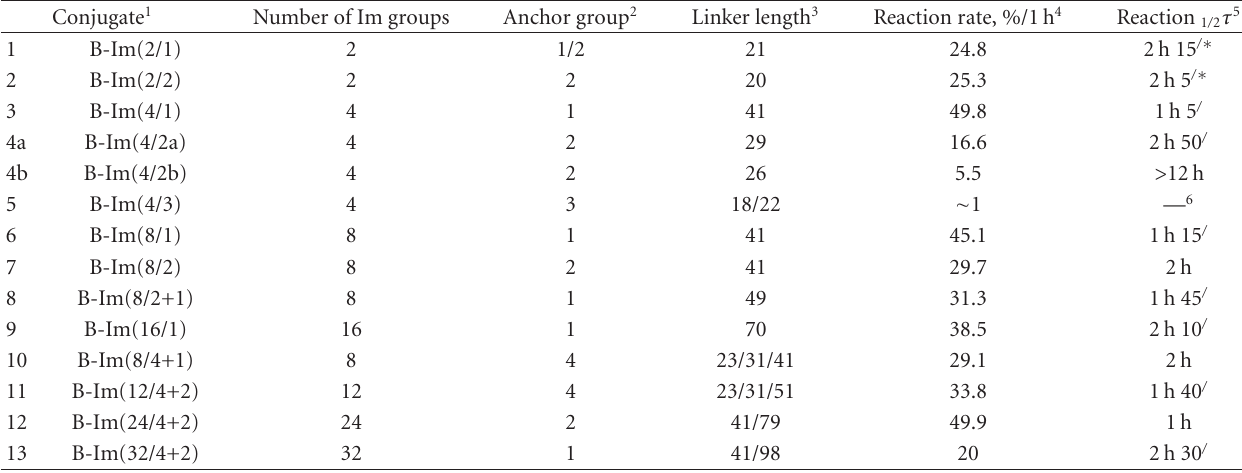
Table 1: Oligonucleotide-based artificial ribonucleases bearing multiple imidazole groups in the catalytic part: structure of conjugates and e ffi ciencies of site-specific cleavage of yeast tRNA Phe